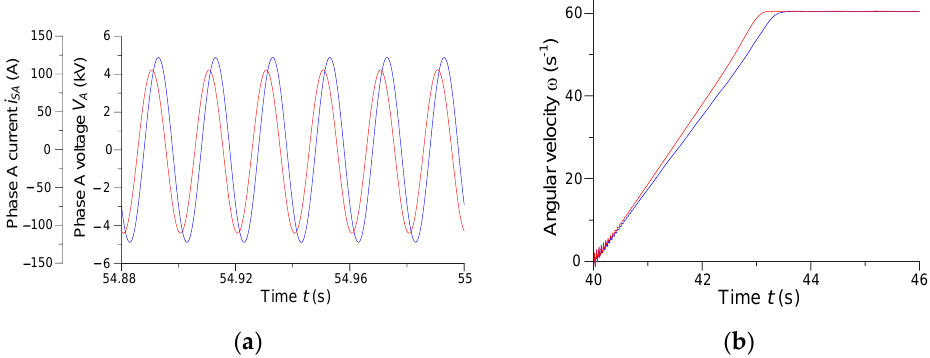
Figure 20. Instantaneous waveforms of: ( a ) phase A voltage (blue) and current (red) across the motor armature winding; and ( b ) angular velocities of the first asynchronous rotor (blue — the second experiment, red — the third experiment).